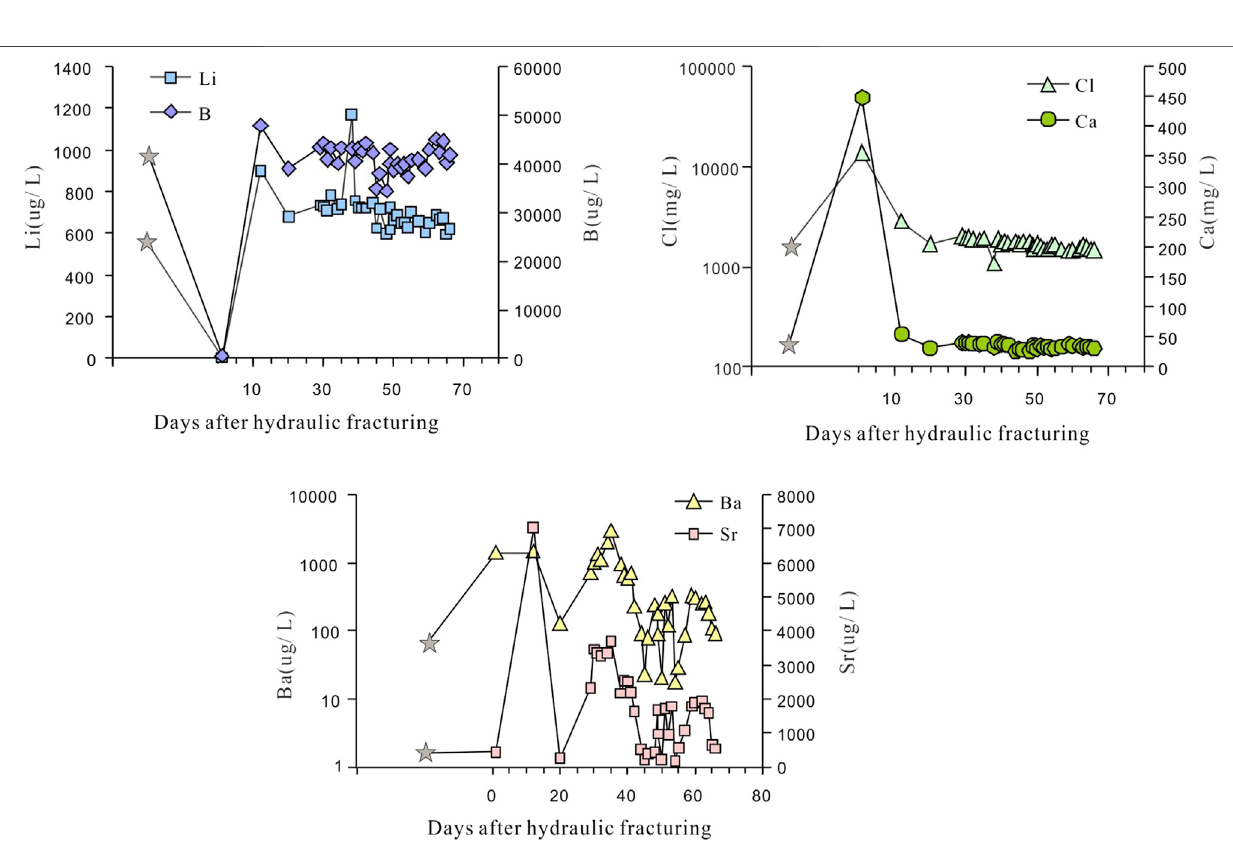
Frontiers in Earth Science |